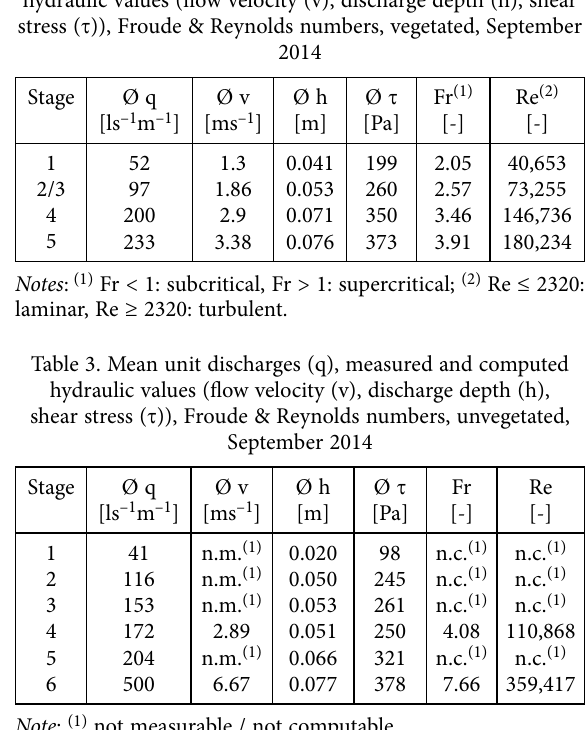
Table 4. Max. cumulative soil loss (CSL) and hydraulic forces, short-term tests series, vegetated, September 2014 Flume Max. CSL